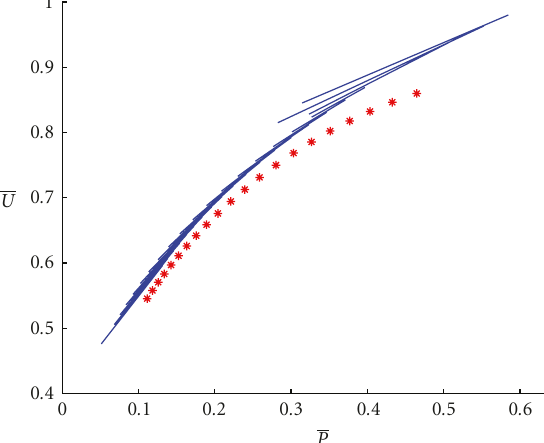
Figure 5: ADP controllers (red), and prescient upper bound